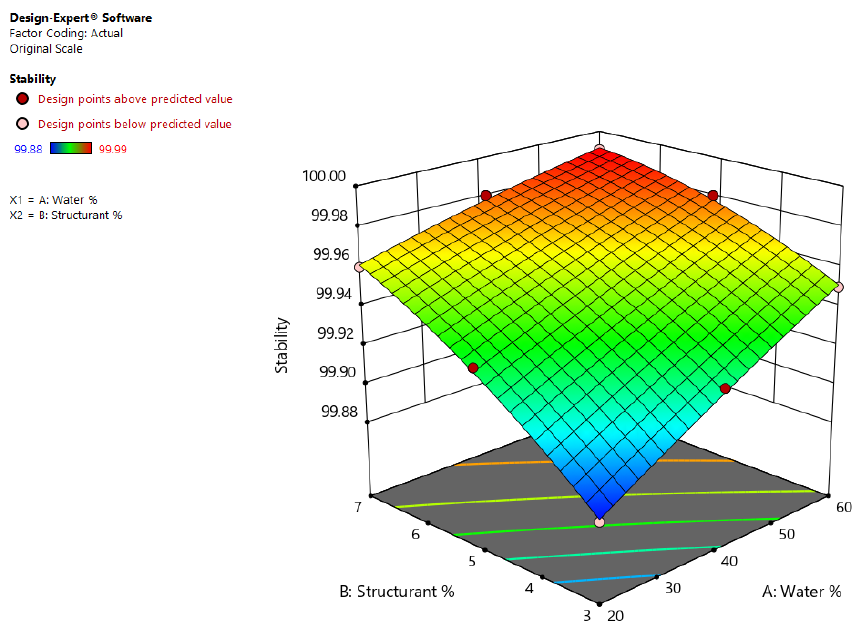
Figure 6. Effects of wax and water concentration on Stability of shellac wax-based oleogel emul- sions.